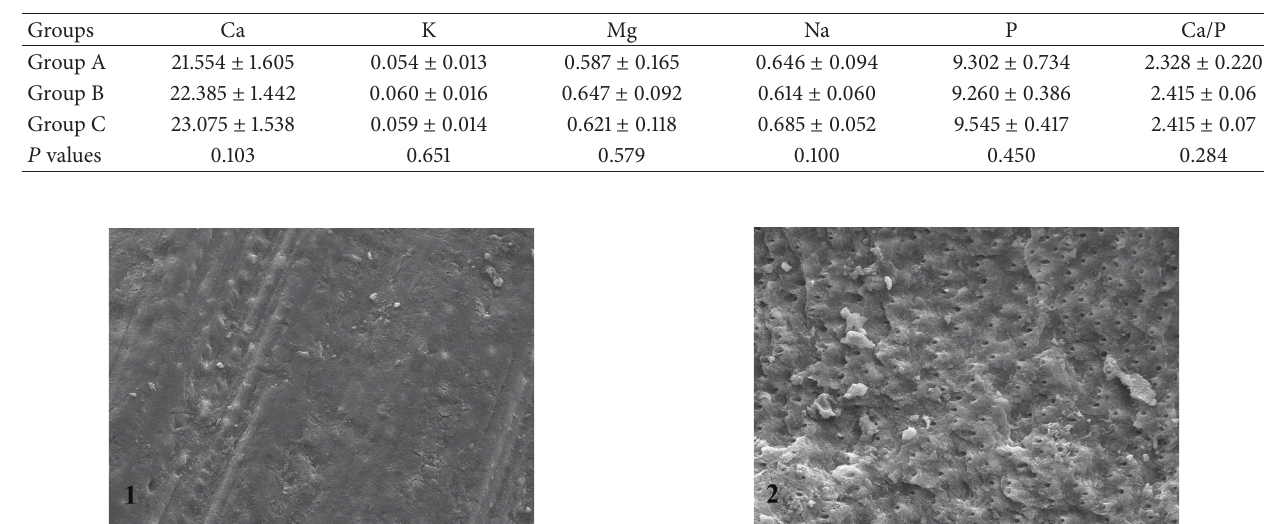
Table 1: Mean percentage weights of the five elements (mean ± standard deviation) and Ca/P ratio according to groups ( 𝑛 = 34 per group).